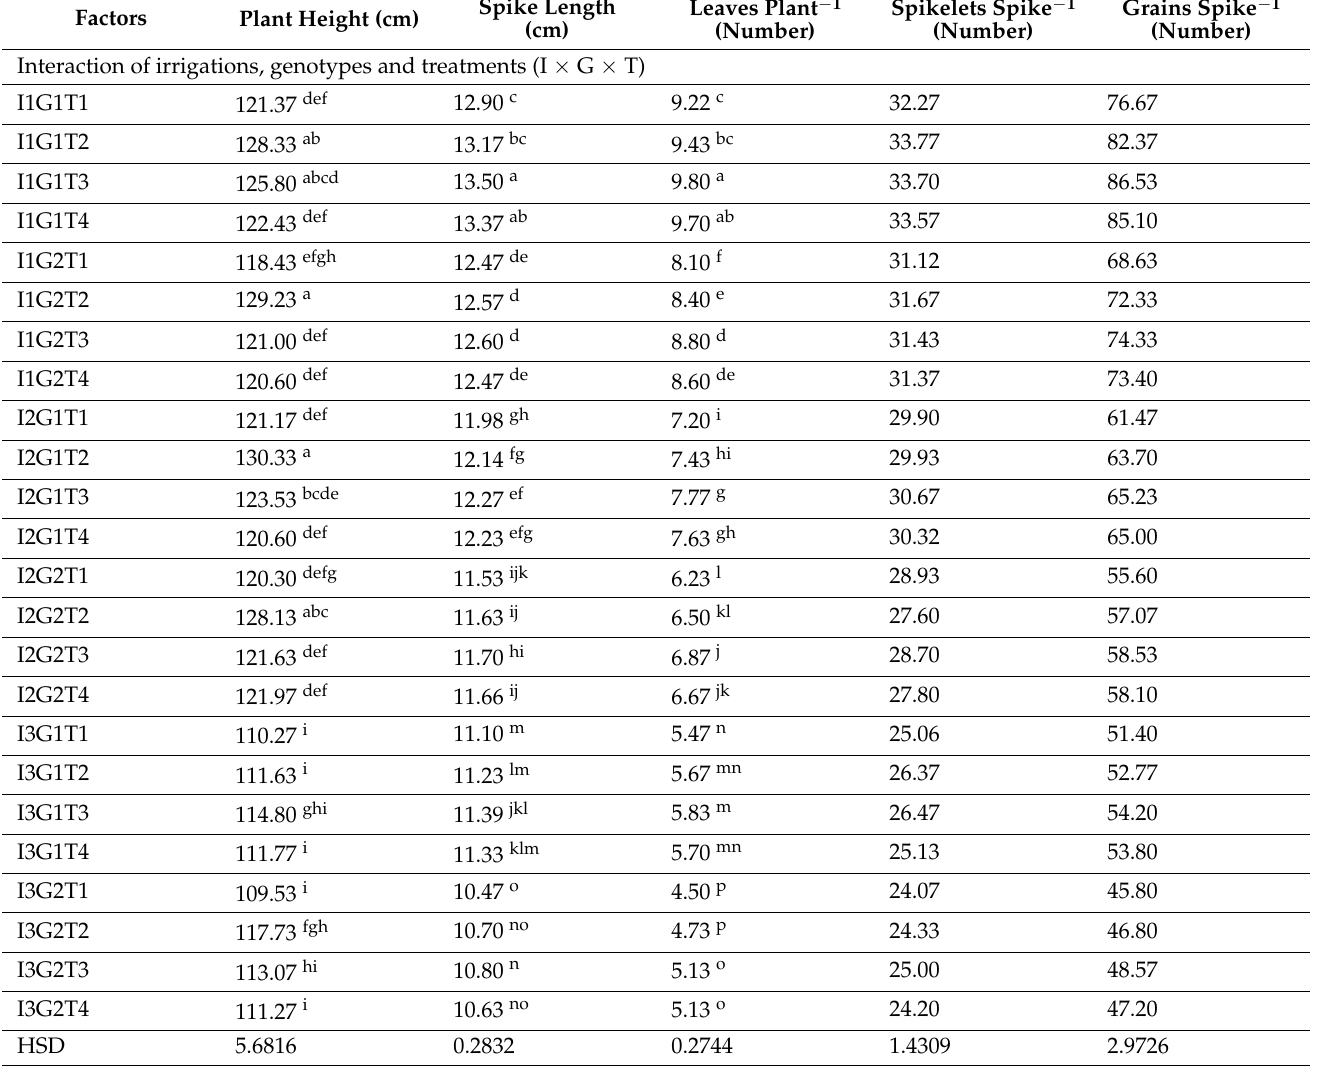
Table 6. Interactive response of all factors regarding plant height, spike length, number of leaves per plant, number of spikelets per spike and number of gains per spike of triticale genotypes.